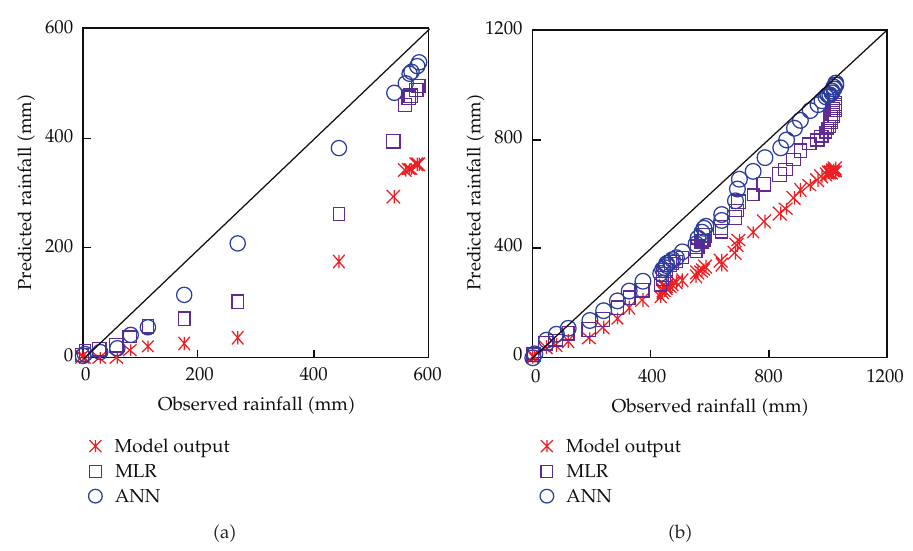
Figure 4: Comparison of accumulative rainfall between observation and prediction obtained from model output and downscale using MLR and ANN for single storm event (cid:2) a (cid:3) on Sep. 26–30th, 2009 and continuous storm event (cid:2) b (cid:3) on Nov. 17th–27th,